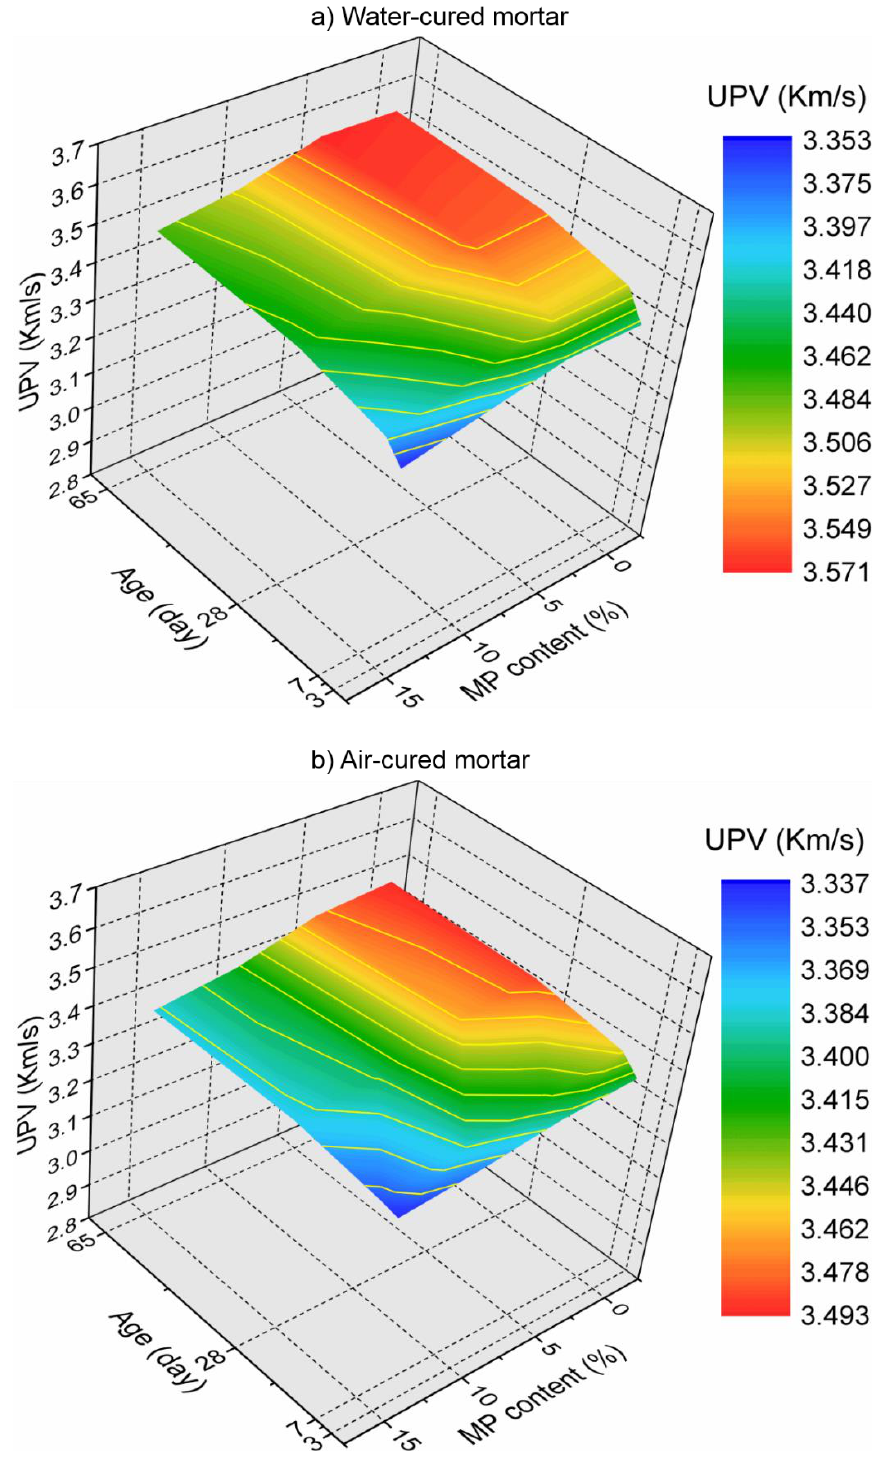
Figure 5. Effect of the incorporation of MP on mortar’s UPV at 3 to 65 days, ( a ) water-cured mortar; ( b ) air-cured mortar.